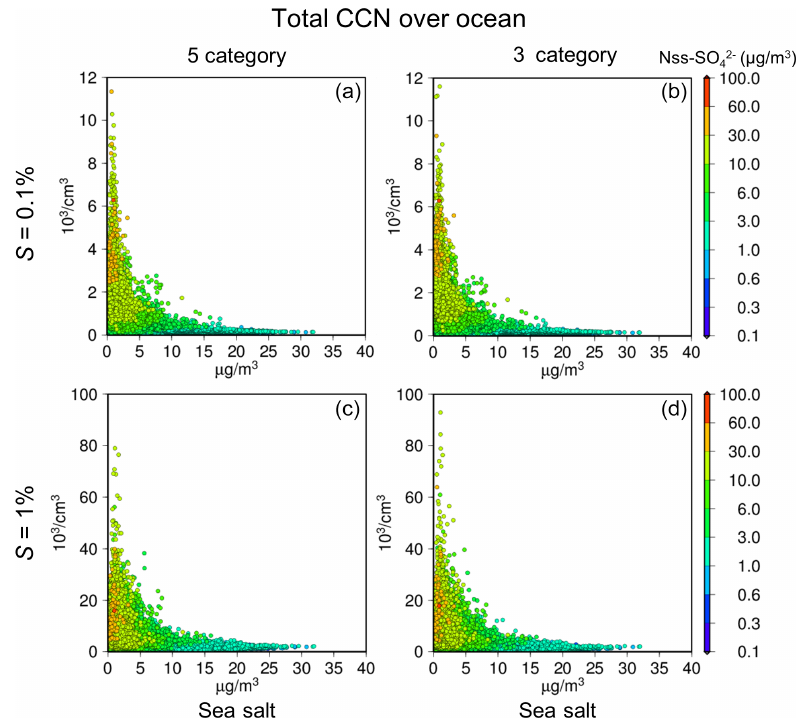
Figure 12. Scatter diagrams between the daily mean, averaged below 1kma.g.l., total CCN number concentrations ( y axis) and dry mass concentrations of sea salt ( x axis) with nss-SO 2 − concentrations (colors) over the ocean grids for 2006. The number of data points was 4 randomly reduced to approximately 1 / 20 to avoid too much overlapping of the points at supersaturation conditions of (a, b) 0.1% and (c, d) 1% for (a, c) the five-category and (b, d) three-category